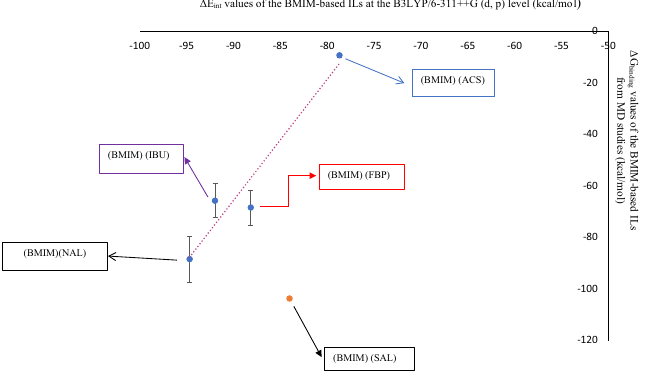
Figure 6. Correlation between ΔG binding (kcal mol −1 ) from 20 ns of MD simulation and ΔE int (kcal mol −1 ) from QM studies in: (BMIM) (ACS), (BMIM) (FBP), (BMIM) (IBU), and (BMIM)(NAL), (error bar % = 10).